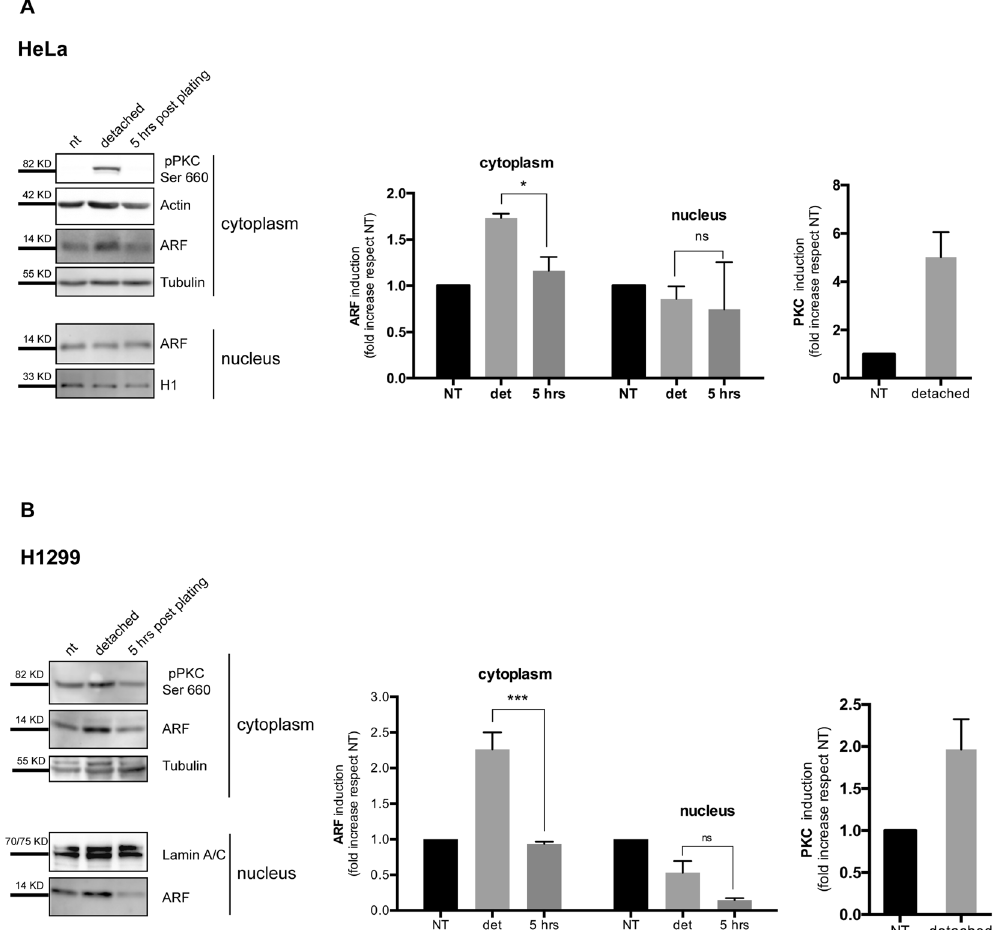
Figure 2. Active PKC and ARF protein levels increase upon detachment. ( A ) Fractionated cellular extracts of HeLa cells were analysed by IB with anti-pPKC Ser660, anti-ARF, anti-actin, anti-ß-tubulin (cytoplasmic loading control), and anti-histone H1 (nuclear loading control) antibodies. Representative western blots are shown. ( B ) H1299 cells were treated as in ( A ), except than lamin A/C was used as nuclear normalizer. Quantification of PKC and ARF band intensities, performed with ImageJ (See M&M for details), are expressed as fold enrichment respect to NT sample, arbitrarily set to 1. Error bars indicate S.D., n = 3. * P = 0.0124; *** P = 0.0007 by two-tailed unpaired